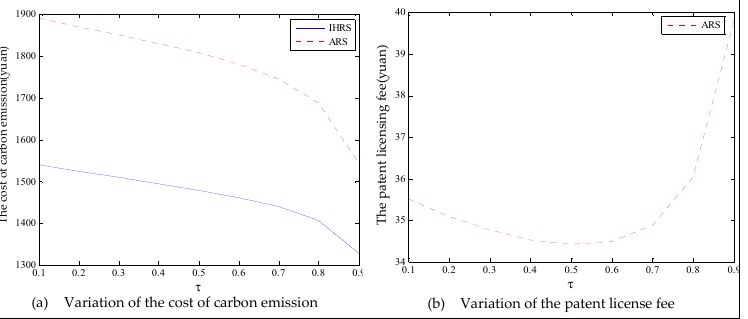
Figure 23. Changes in the carbon emission costs and patent licensing fee in Case 2 of Section 6.3.